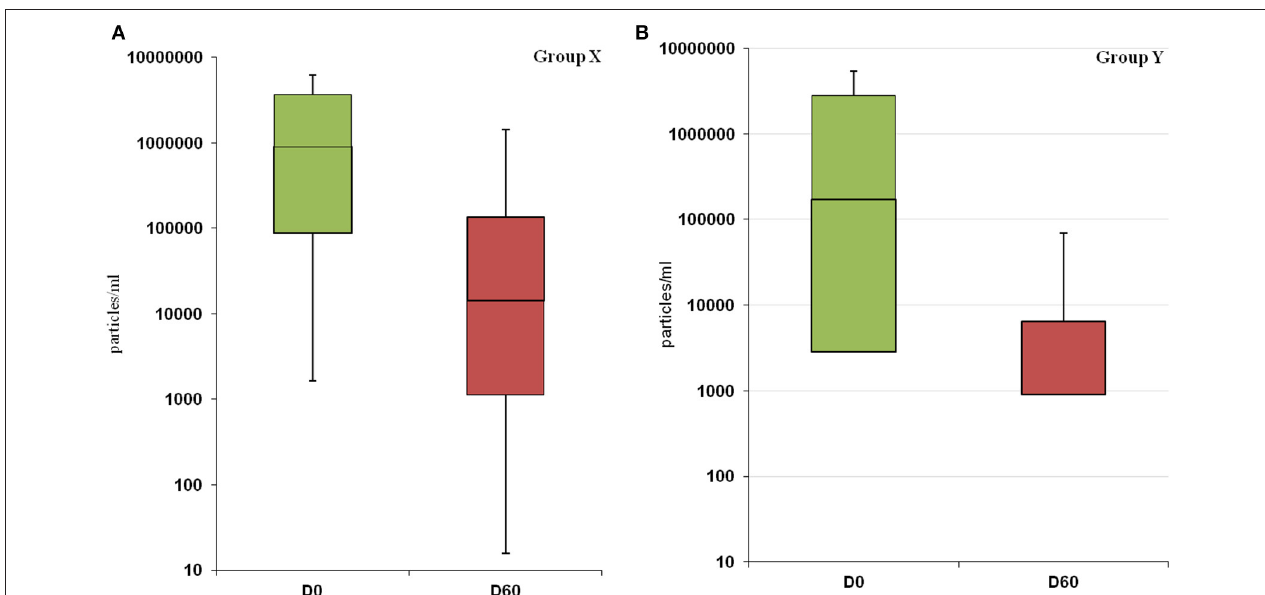
FIGURE 2 | Changes in parasitic load following treatment in group X (A) and Y (B) . The decrease in parasitic load is not statistically significant in both groups (X: p -value = 0.21; Y: p -value = 0.08).